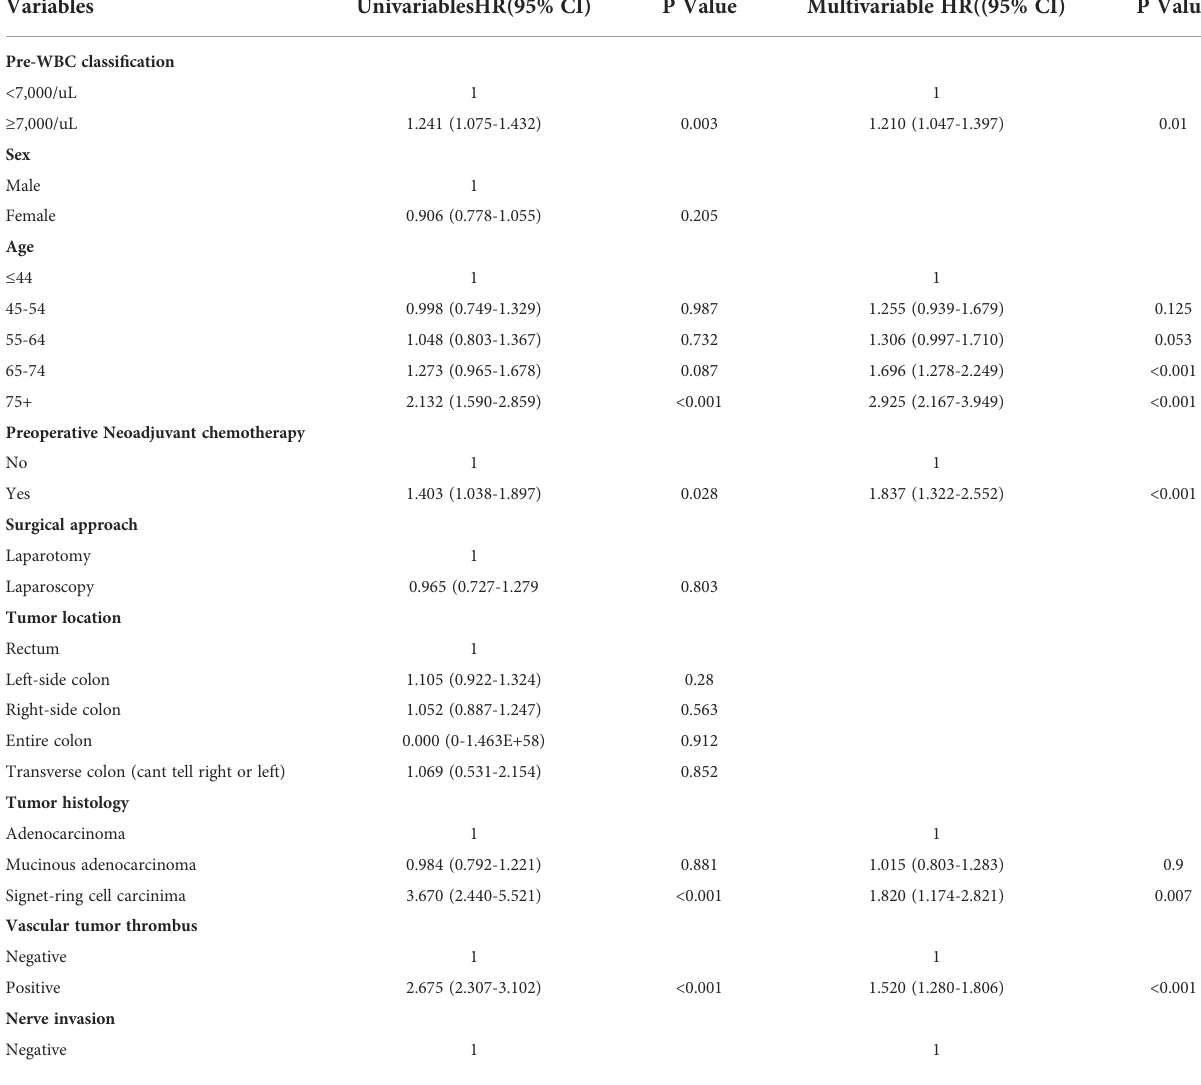
TABLE 3 Univariable and multivariable cox regression analysis for disease-free survival in the propensity score matched cohort.